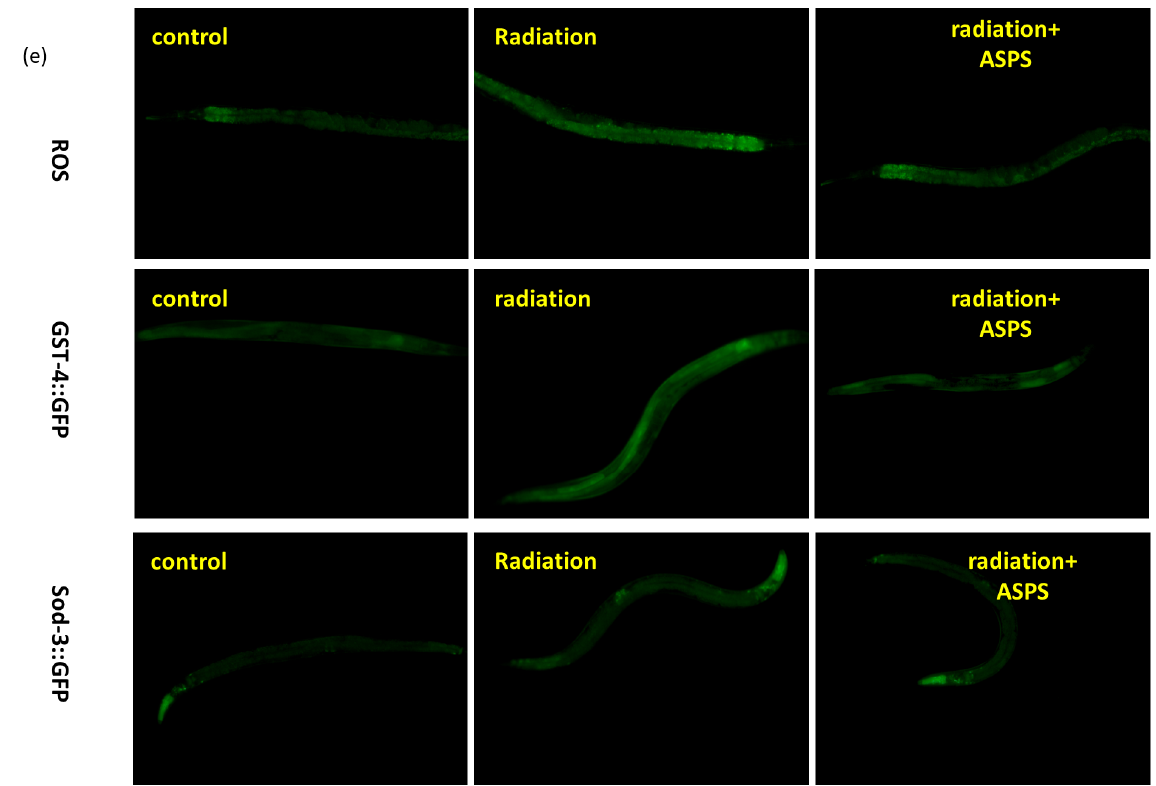
Figure 7. ASPS regulated oxidative stress. ( a ) The expression of canonical oxidative stress genes. n = 3. ( b )–( d ) Quantification of the fluorescence intensity of the microscope pictures. n = 20. ( e ) Fluorescence pictures of ROS, gst-4 ::GFP, sod-3 ::GFP reporter worms. Significant difference from the control group was designated as * p < 0.05 and ** p < 0.01, and significant difference from the radiation group was designated as # p < 0.05 and ## p < 0.01, respectively.